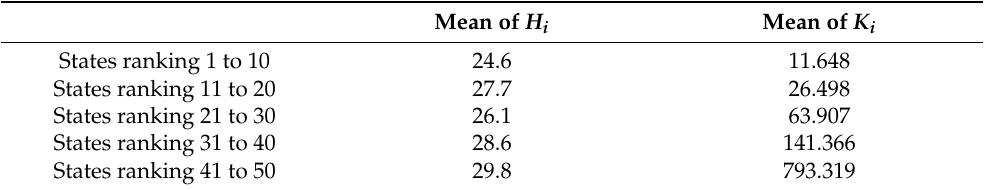
Table 6. Mean of the number of days in the outbreak period ( H i ) and the average daily positive increase ( K i ).